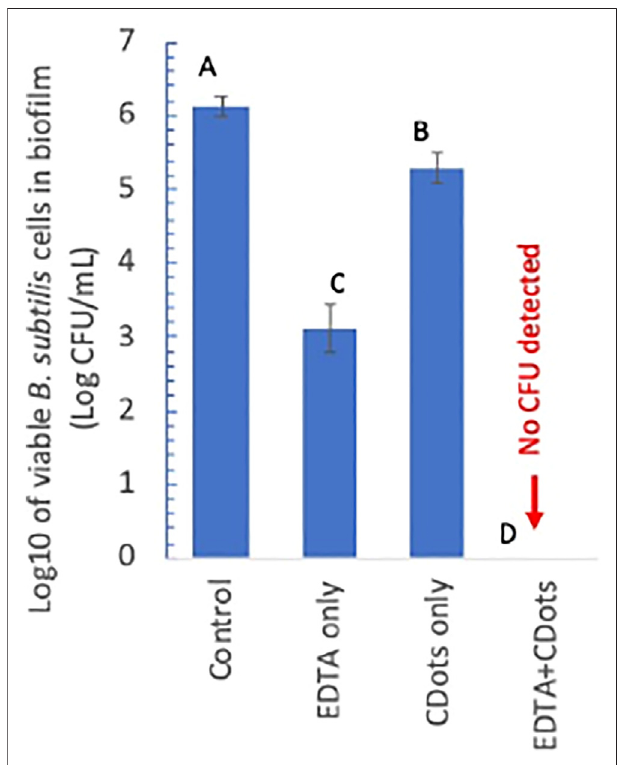
FIGURE 5 | log10 of viable cell numbers in the bio fi lm-associated B. subtilis cell suspensions treated with 5 mM EDTA alone, 30 μ g/mL CDots alone, and the combination of EDTA and CDots along with the untreated control. Different letters above the columns indicate statistically signi fi cant differences with p <